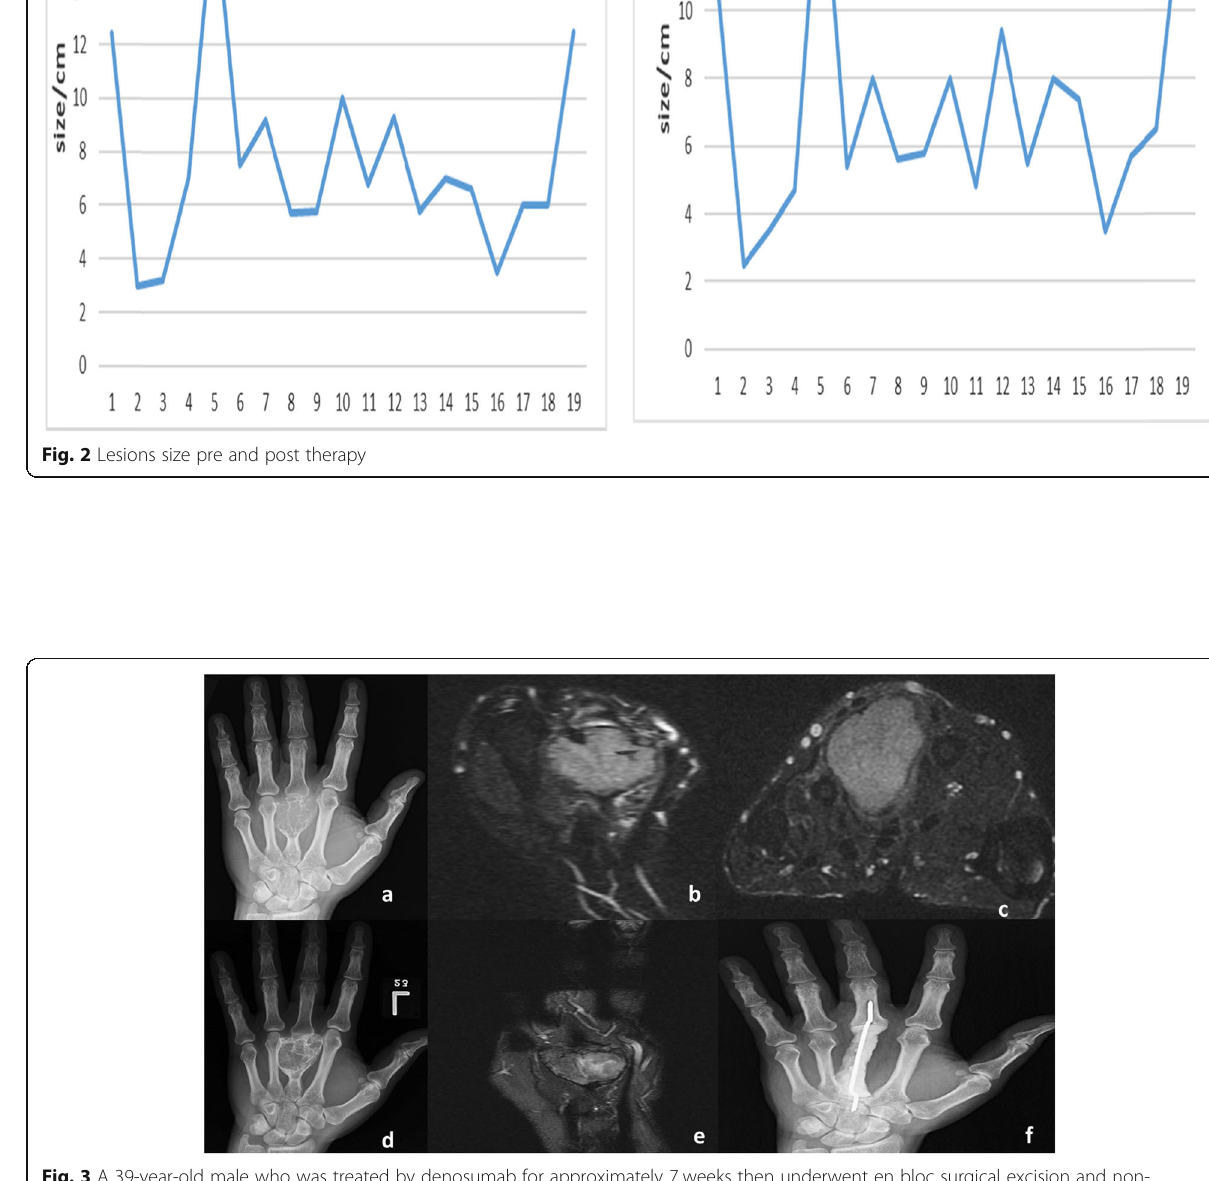
Fig. 3 A 39-year-old male who was treated by denosumab for approximately 7 weeks then underwent en bloc surgical excision and non- biological reconstruction by cement/K-wire. Plain radiograph ( a ) and MRI ( b ) before treatment shows expansile metacarpal lytic lesion with corresponding high FS T2WI internal signal, and after treatment demonstrates marginal sclerosis and internal ossification on the X-ray ( d ) and newly developed areas of intermediate signal on follow-up MRI ( e ). Post-operative AP radiograph ( f